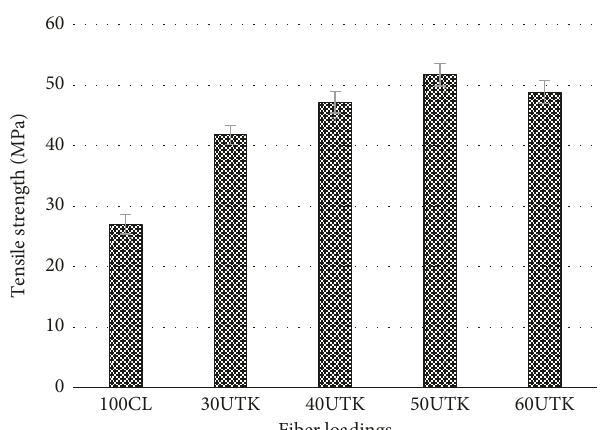
Figure 4: Tensile strength (MPa) vs. fiber content.